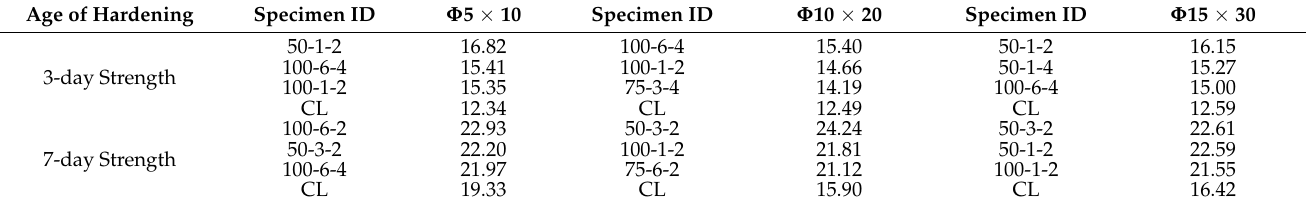
Table 4. Top 3 compressive strengths of all ages of normal concrete cured with CO 2 (unit: